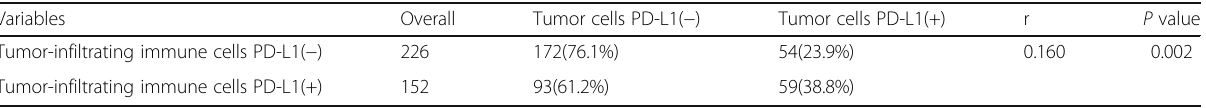
Table 4 The relationship between tumor cells and tumor-infiltrating immune cells for PD-L1 expression